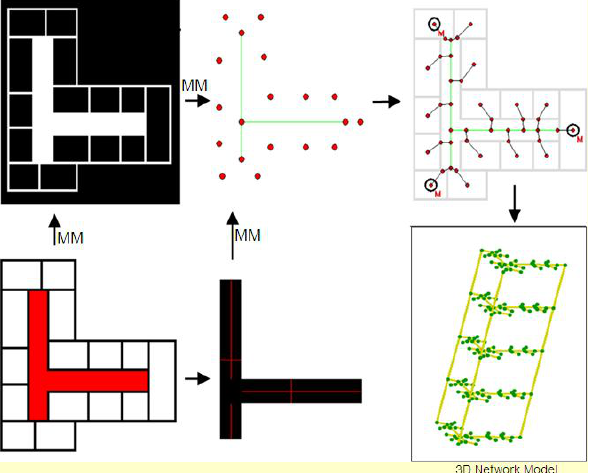
Figure 7. 3D Network Generation Process by using MUSCLE Model